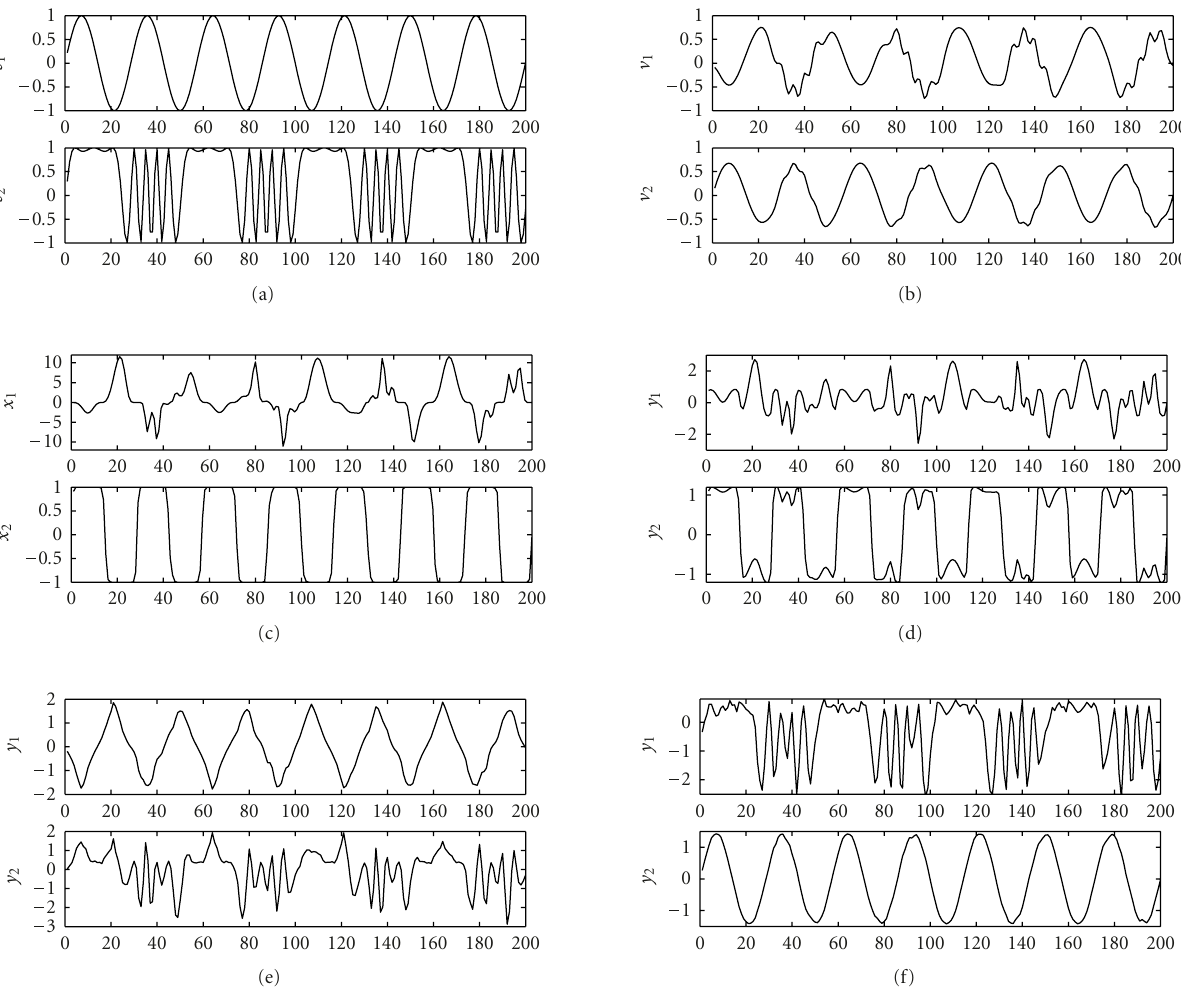
Figure 10: Plots of 200 signal samples. (a) Unknown sources. (b) Linear mixtures. (c) PNL mixtures. (d) SOBI estimates. (e) Gauss-TD estimates. (f) gpICA